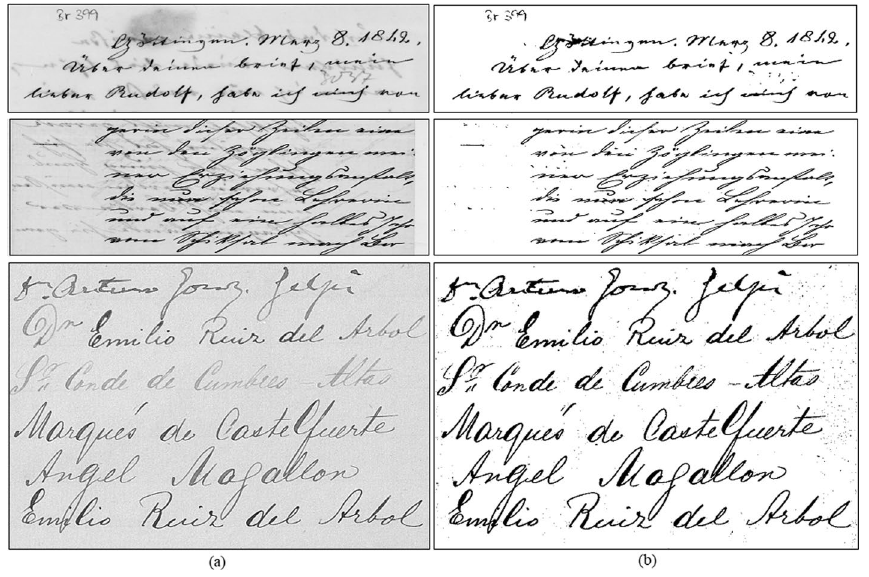
Fig. 7 Images binarization results from DIBCO 2016: a Original degraded images, b recovered text by the proposed non-local